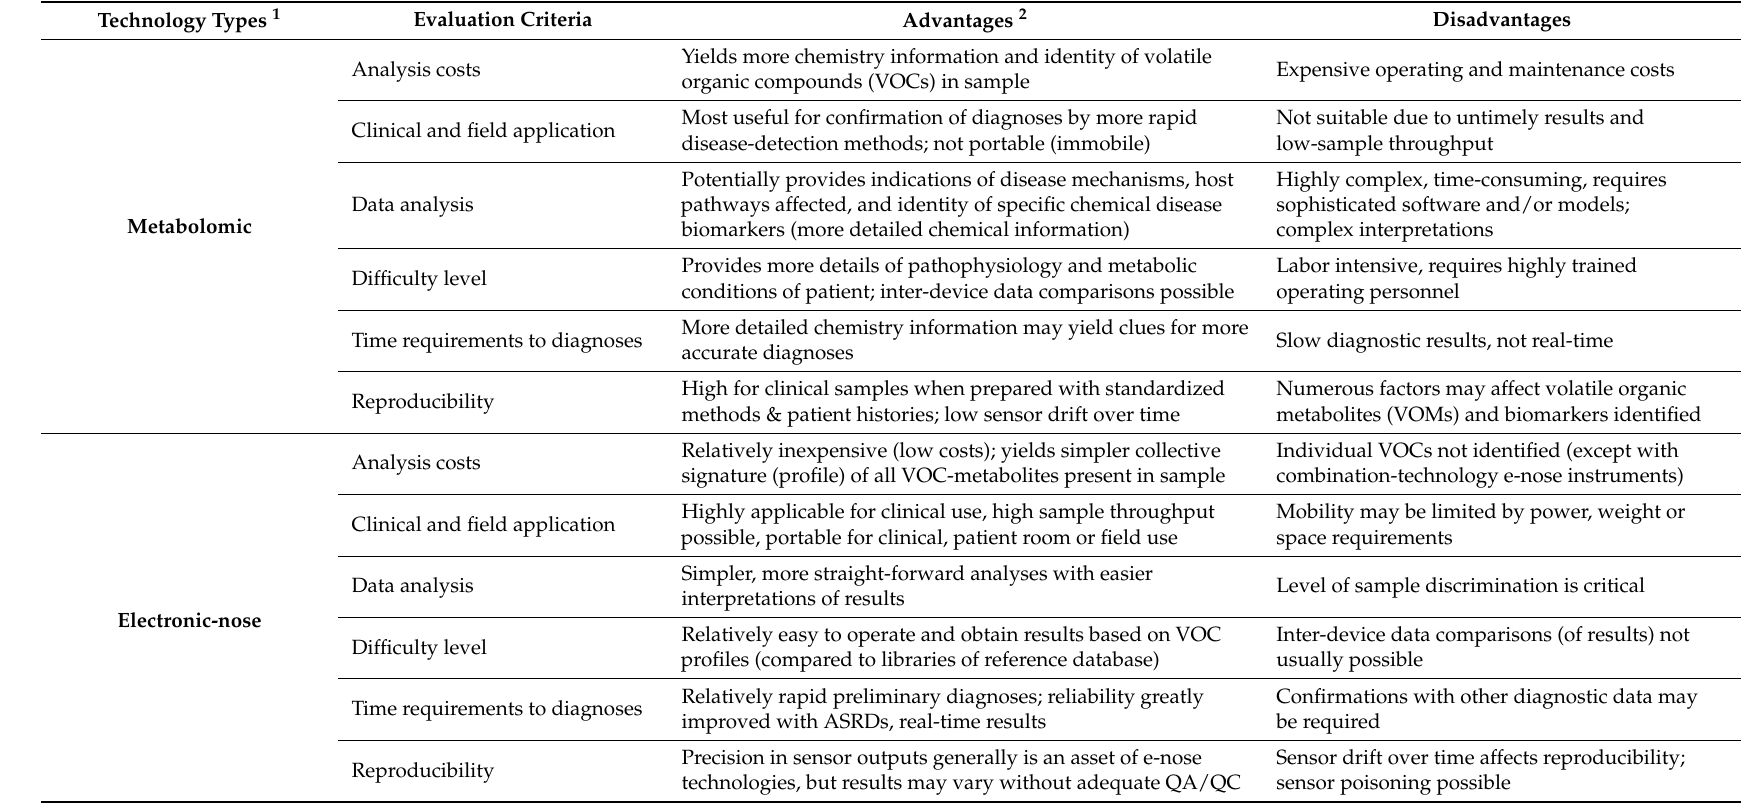
Table 1. Comparisons of key advantages and disadvantages of metabolomic verses electronic-nose analytical technologies for clinical disease detections and diagnoses. Technology Types